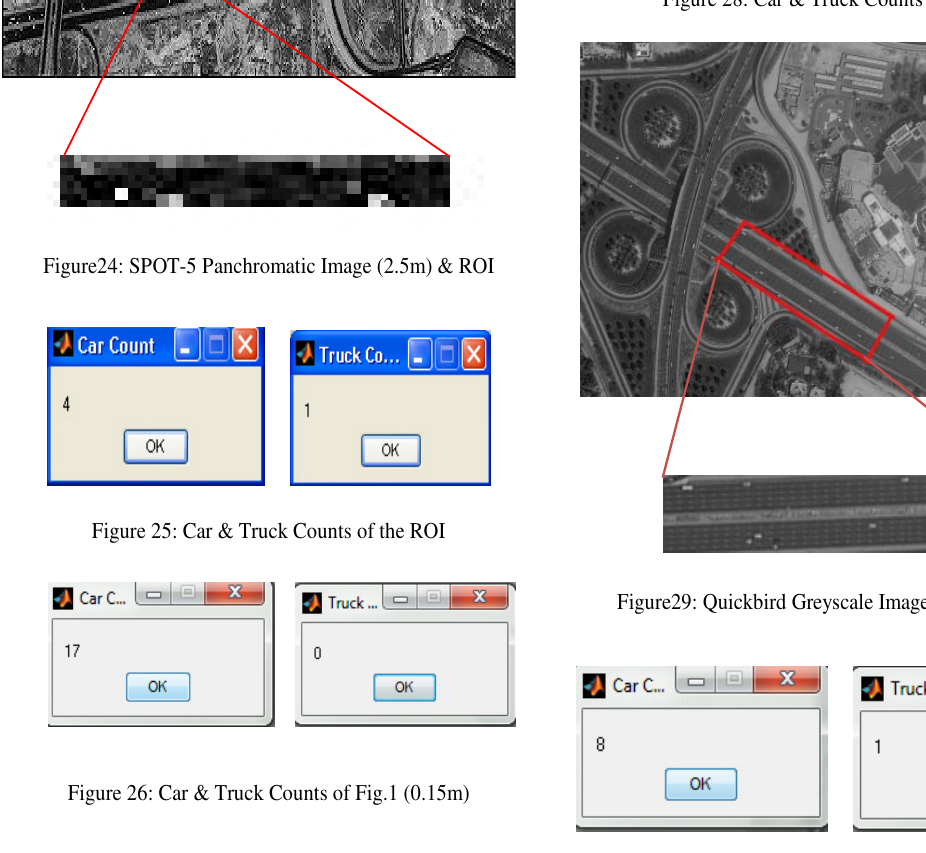
Figure 28: Car & Truck Counts of the ROI